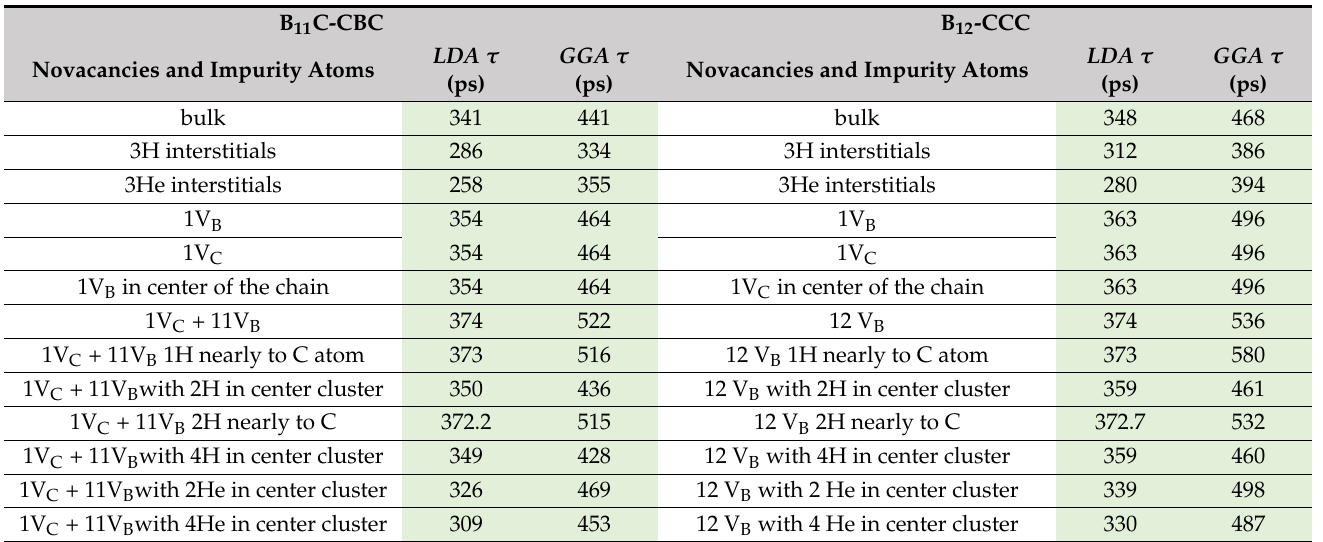
Table 2. The calculated values for τ in a growing nanocluster of point defects and H and He